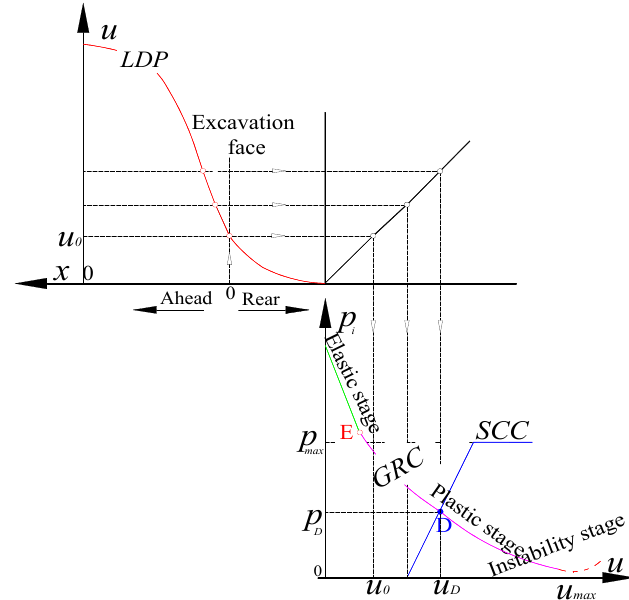
Figure 2. Schematic diagram of CCM.